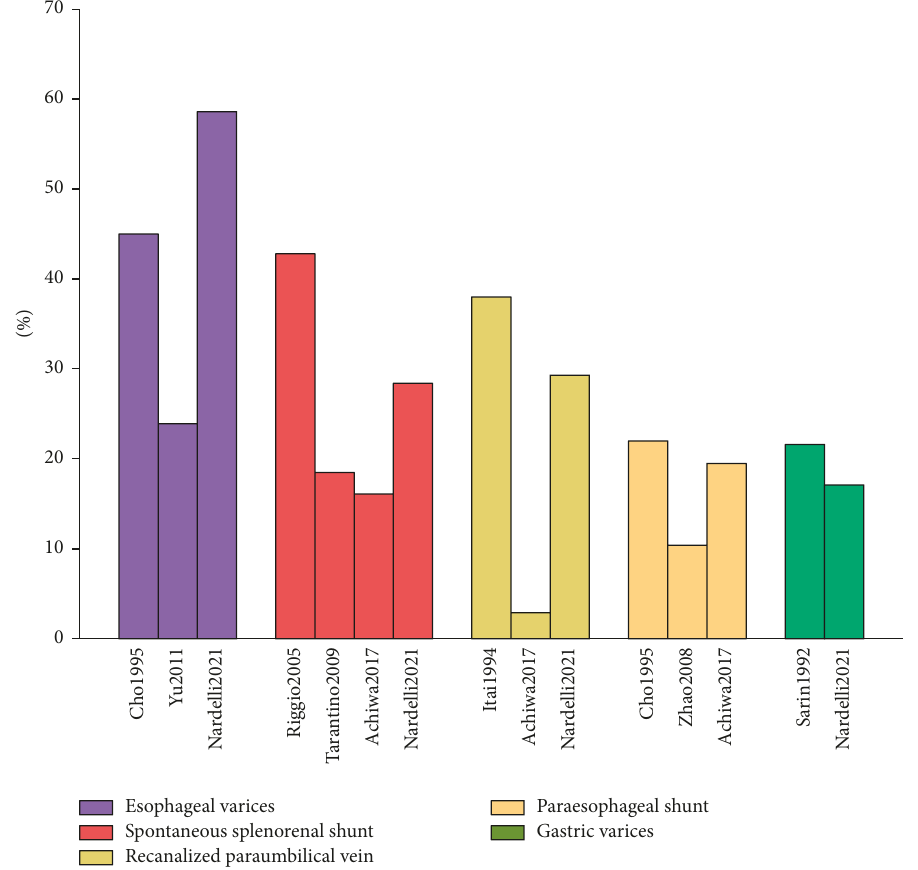
Figure 2: Prevalence of various types of SPSS on the contrast-enhanced CT